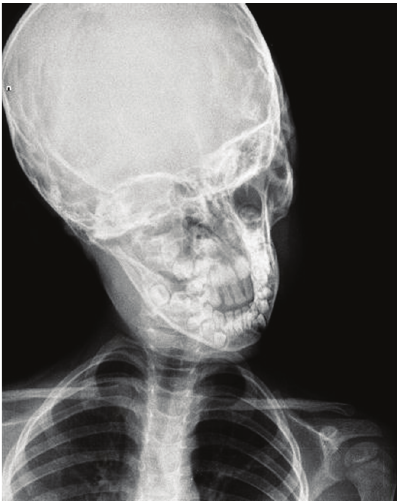
Figure 1: Cock-robin position on anterior-posterior direct cer- vicography.